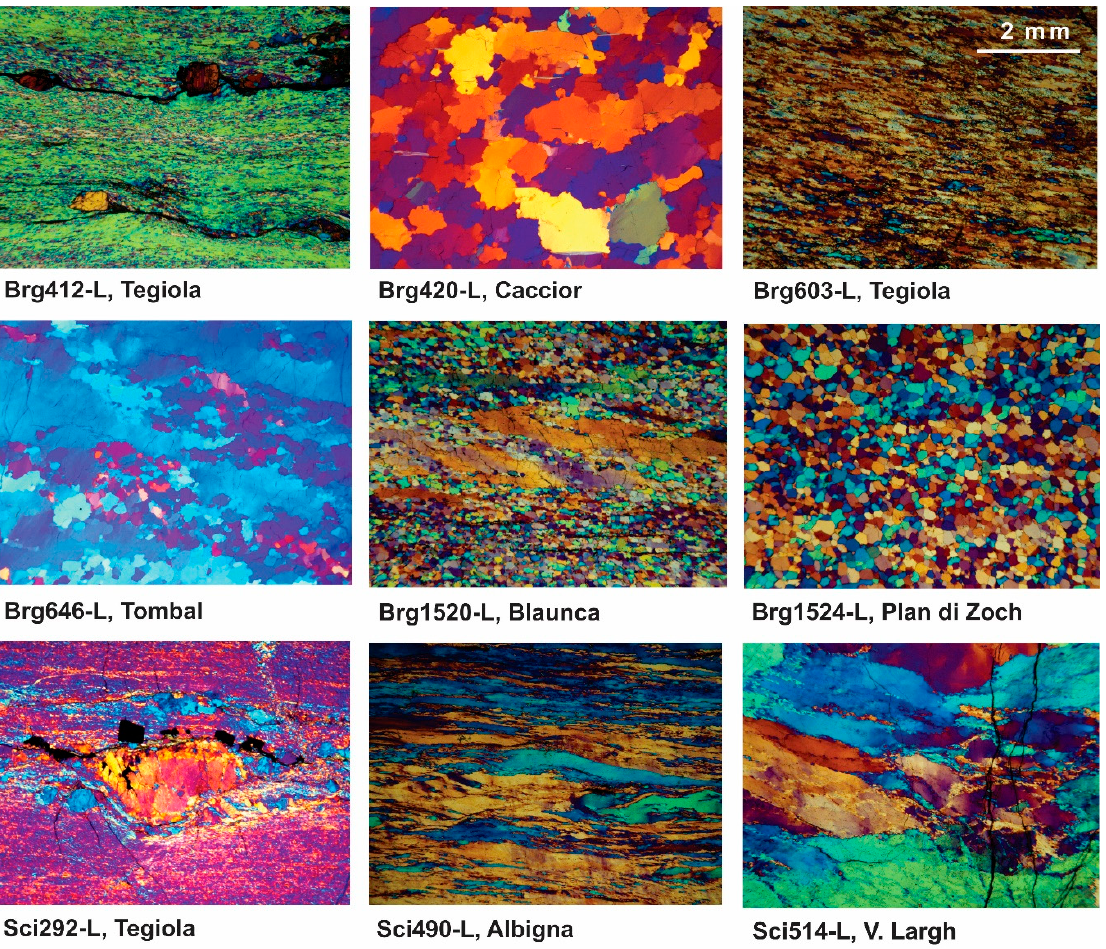
Figure 4. Optical images of thin sections from selected quartz layers. Crossed polarizers, gypsum plate inserted to highlight orientation differences. Scale indicated at top right. For more images with crossed polarizers only see Supplementary Material Figure S2. Order of samples is the same as in Table 1. The large clasts in Brg412 and Sci292 are feldspar.